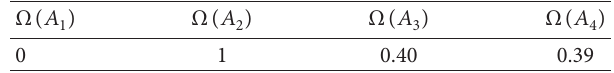
Table 14: Relative weights.